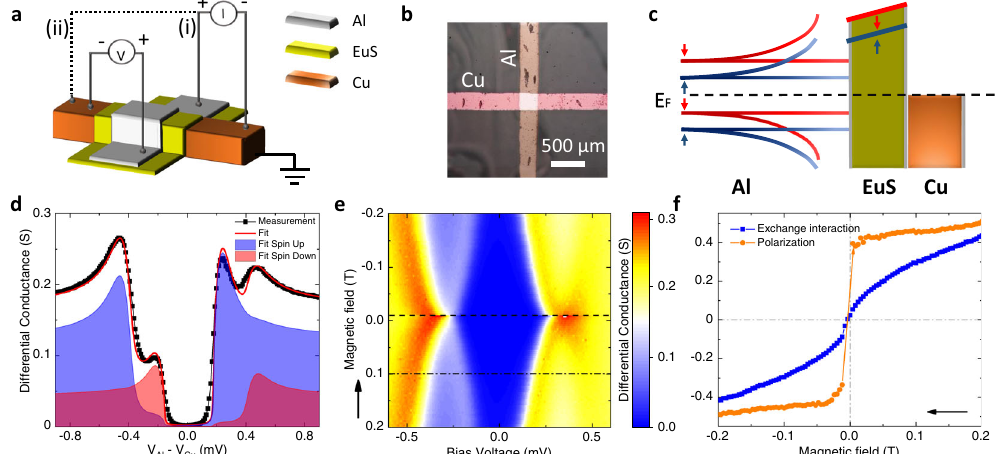
Fig. 1 Working principle and characteristics of the superconducting tunnel diode. a Schematic of the device structure: a Cu strip (orange) is covered by a EuS layer (green) and a perpendicular Al strip (gray). Measurement setups: The electric current is applied (i) from the Al to the Cu strip or (ii) along the Cu strip. The voltage drop is measured between the Al and the Cu strip on the remaining two wires of the four-wire set-up. b Visible light microscopy image of the device. c Schematic of the DoS along the vertical axis of the structure (Al/EuS/Cu from top to bottom). The dashed line indicates the Fermi level. Note that the EuS layer induces spin splitting in the superconducting DoS, and spin fi ltering thanks to the different heights of the tunnel barrier for the two spin species. The red (blue) line corresponds to the spin up (down) DoS in the Al layer. d Exemplary differential conductance (black) measured as a function of voltage across the junction at an applied external magnetic fi eld B of 0.1 T at ≃ 100 mK. By employing a numerical model (detailed in the Methods section, Eqs. (3) and (14)), the fi t for the differential conductance (red) and the contributions of the spin up (light blue) and spin down (light red) electrons were calculated with these fi tting parameters: Δ 0 = 0.33meV, h = 0.32 Δ 0 , P = 0.48, Γ = 0.01 Δ 0 , T = 300 mK. e Color map of the differential conductance dI / dV ( V ) measured for B ranging from − 0.2 T to 0.2 T. The sweep direction is indicated by the arrow. The data in panel d corresponds to the dash-dotted line (B = 0.1 T). The coercive fi eld at the temperature of this measurement (100 mK) corresponds to − 9 mT, indicated by a dashed line. f Exchange fi eld ( h ) induced in the superconducting Al strip (blue) and polarization ( P ) of the EuS tunnel barrier as a function of the external magnetic fi eld B . Both quantities are extracted from the best fi tting results of the data as shown in panel d . The sweep direction is again indicated by an